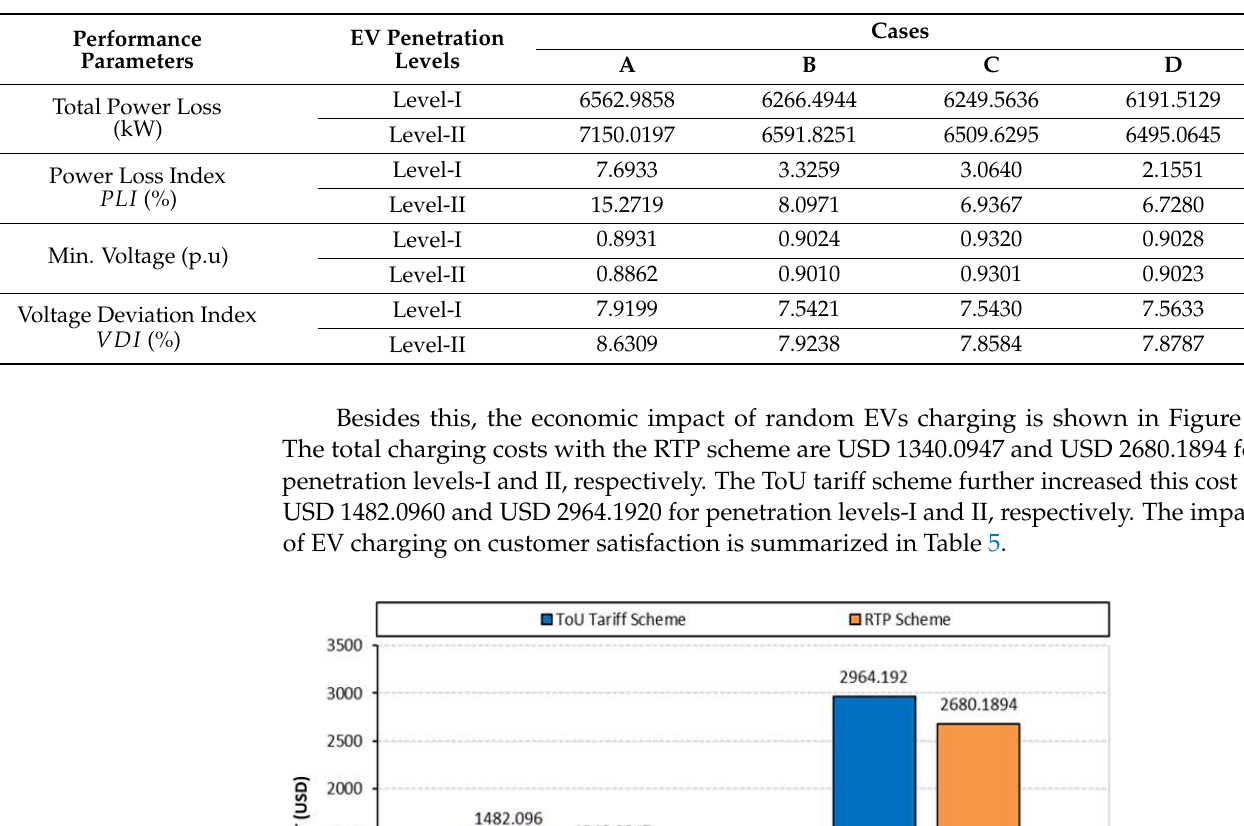
Figure 8. Case A: ( a ) Network power loss; ( b ) voltage deviation; ( c ) network power consumption. Table 4. Impact of EV charging on the network performance for all four cases.